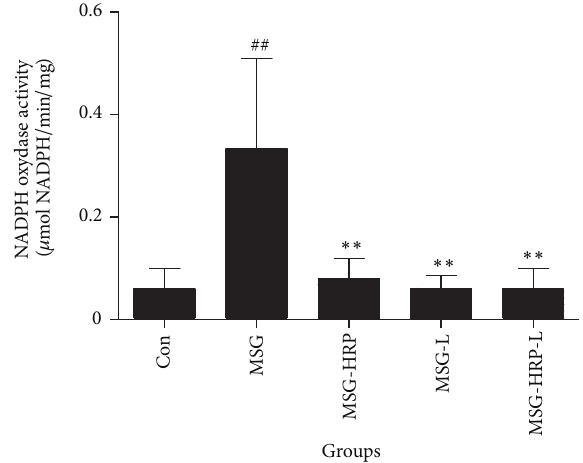
Figure 8: NADPH oxidase activity in pancreatic tissue. ∗∗ Compared with MSG group, 𝑃 < 0.01 ; ## compared with Con group, 𝑃 < 0.01